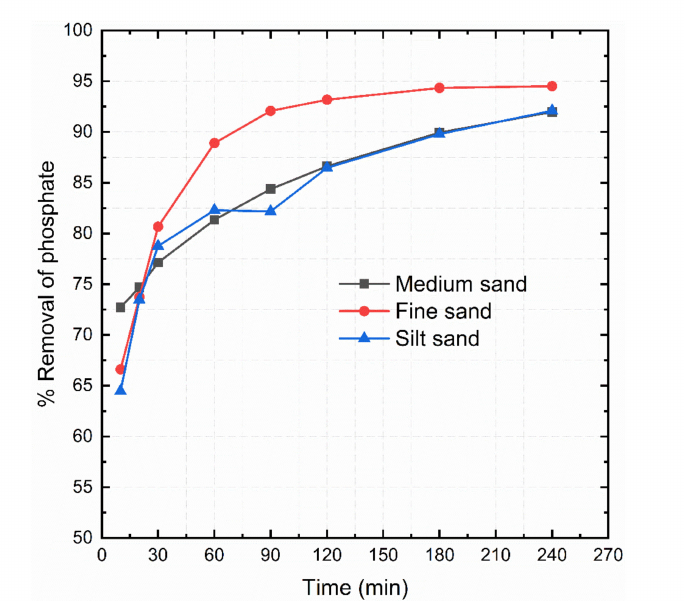
Figure 3. E ff ect of particle size on removal of phosphate (temperature: 20 ◦ C; Co: 10 mg / L; dose 40 g / L; contact time 240